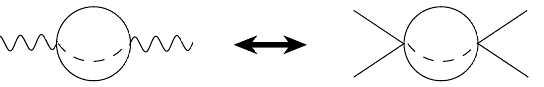
Figure 3 . Left: the dominant \core" diagram contributing to the bb 2-point function in the supersymmetric FGMS model. Right: the dominant ladder \rung" diagram contributing to the 4-point function in the fermionic SYK model. The full set of dominant graphs is generated iteratively using this core (with propagator corrections obtained by also iterating the right panel of (cid:12)gure